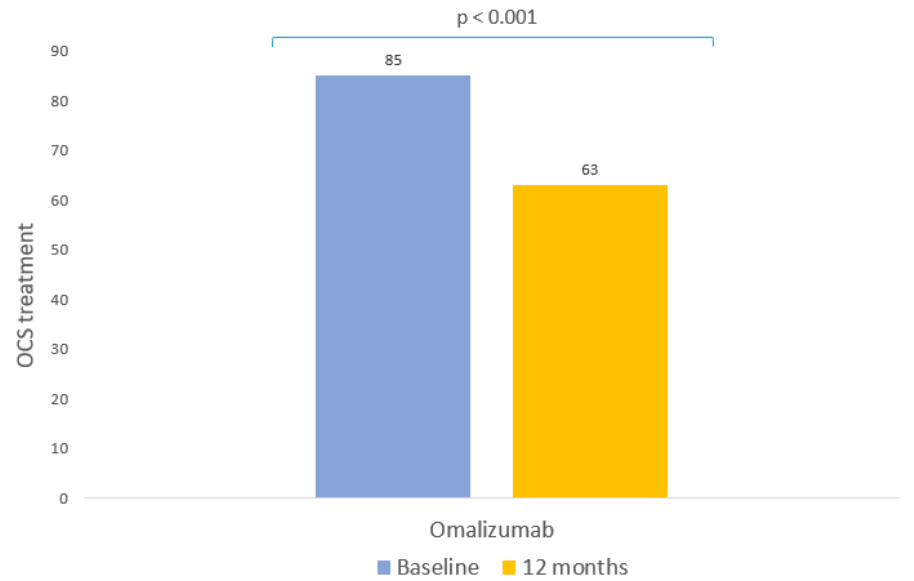
Figure 1. Clinical response to omalizumab: OCS. Patients with oral corticosteroid requirements during the 12 months prior to starting omalizumab and at the follow-up evaluation after 12 months of therapy.